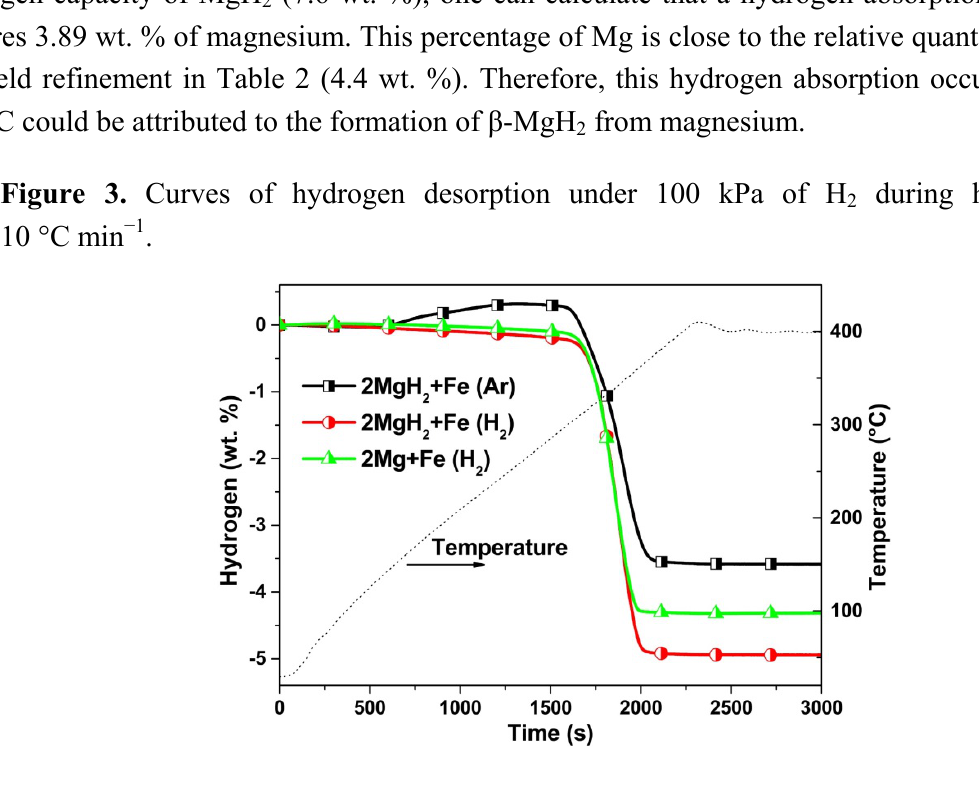
during heating at 2